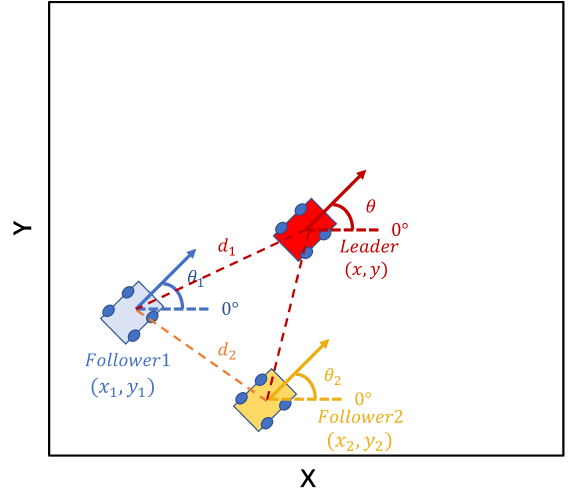
Figure 5. Illustration of the state space of a UGV in a Cartesian coordinate